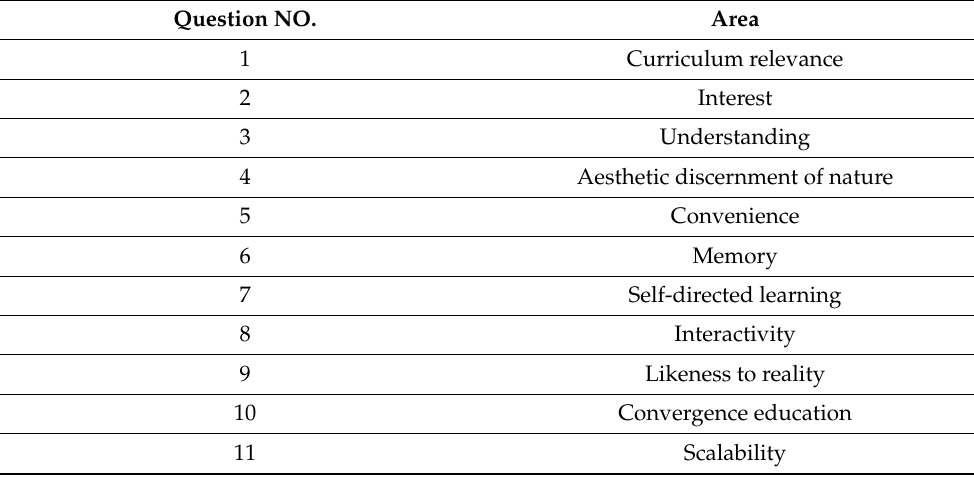
Table 3. Composition of Questionnaire of the VFT program satisfaction survey.